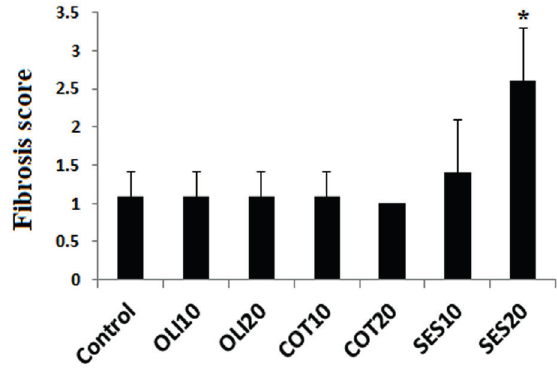
Figure 4 - The extent of renal fibrosis is represented semi- quantitavly by the fibrosis score. Control, Olive10% (OLI10), Olive 20% (OLI20), Cottonseed 10% (COT10), Cottonseed 20% (COT20), Sesame oil 10% (SES10) and Sesame oil 20% (SES20). Values were presented as mean± SD. *p< 0.05 compared to the control